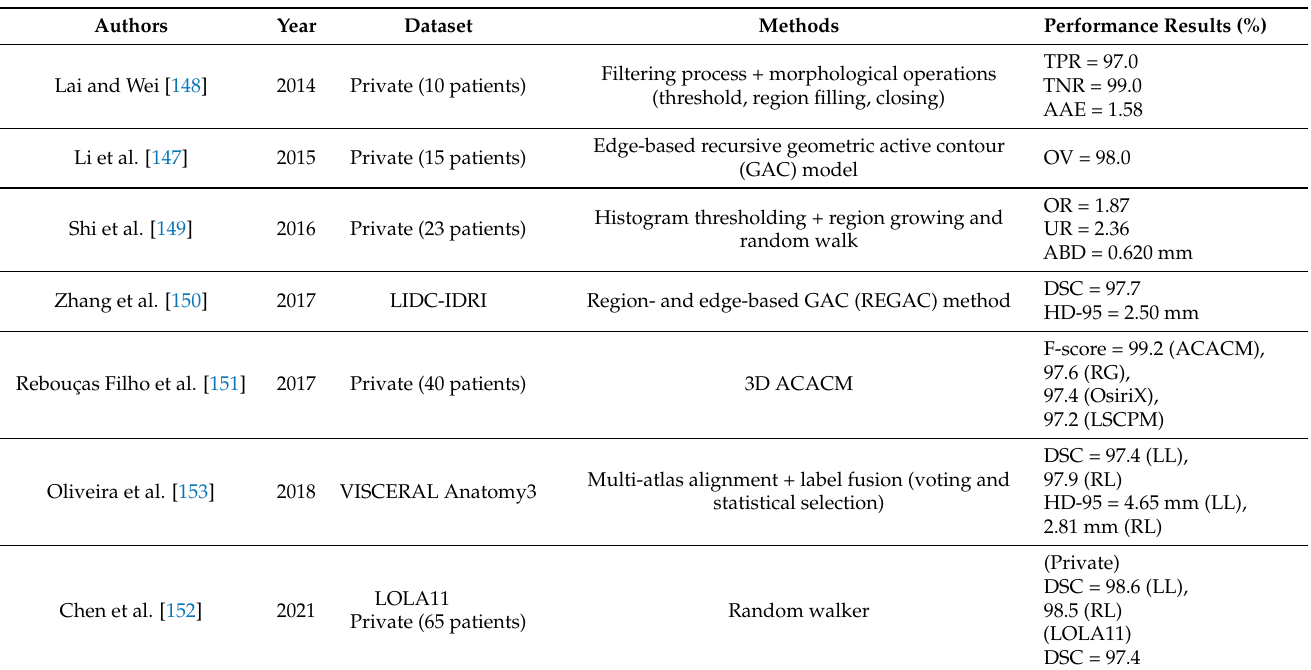
Table 4. Overview of published works regarding conventional methodologies for the segmentation of lung CT images (2014–2021).